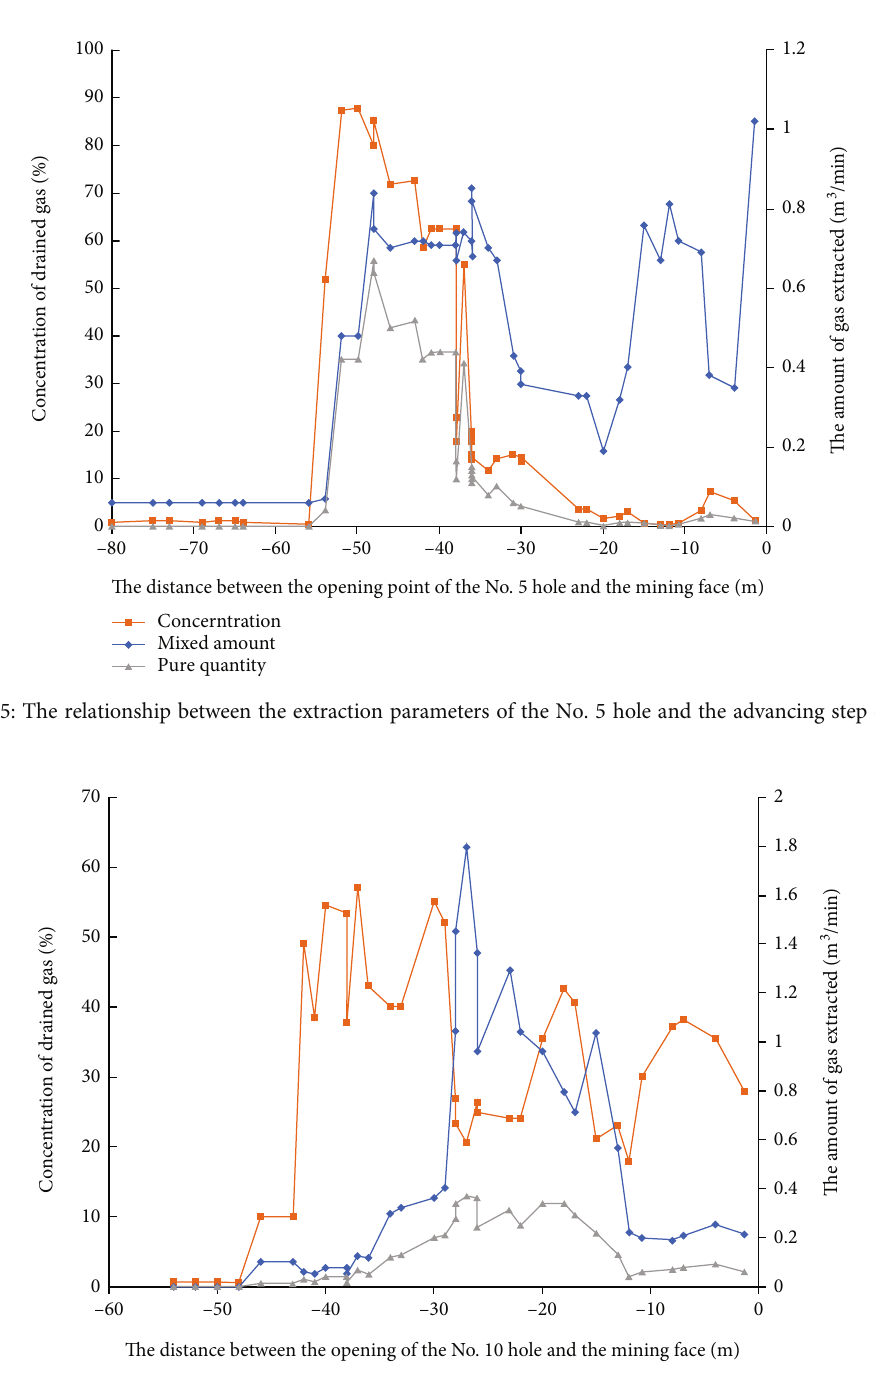
Figure 6: The relationship between the extraction parameters of the No. 10 hole and the advancing step